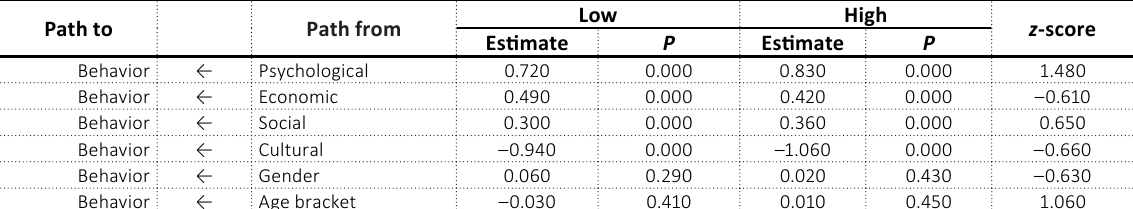
Table 5. Education Path to Path from